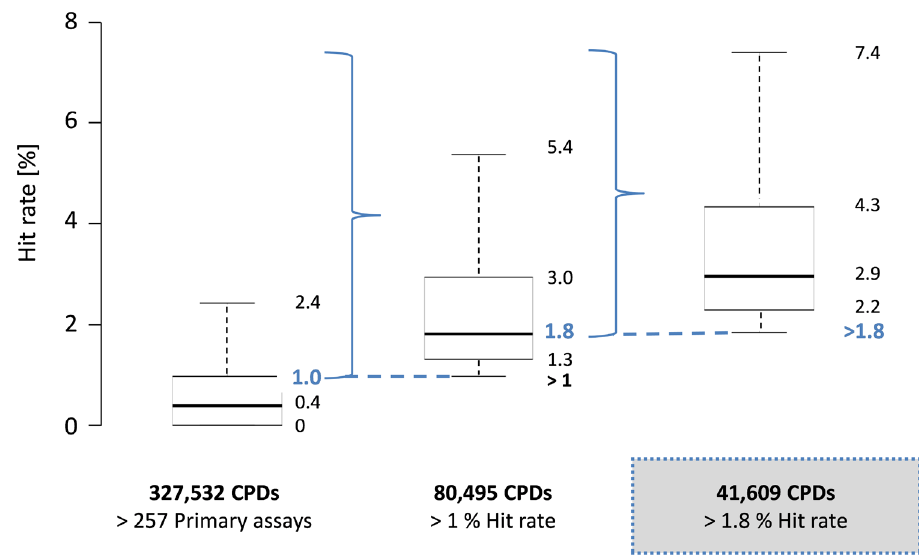
Figure 2. Hit rate distribution. For three different subsets of PubChem compounds, hit rate distributions are shown in boxplots according to Figure 1. The subsets are characterized by increasing hit rates (marked by dashed blue lines).